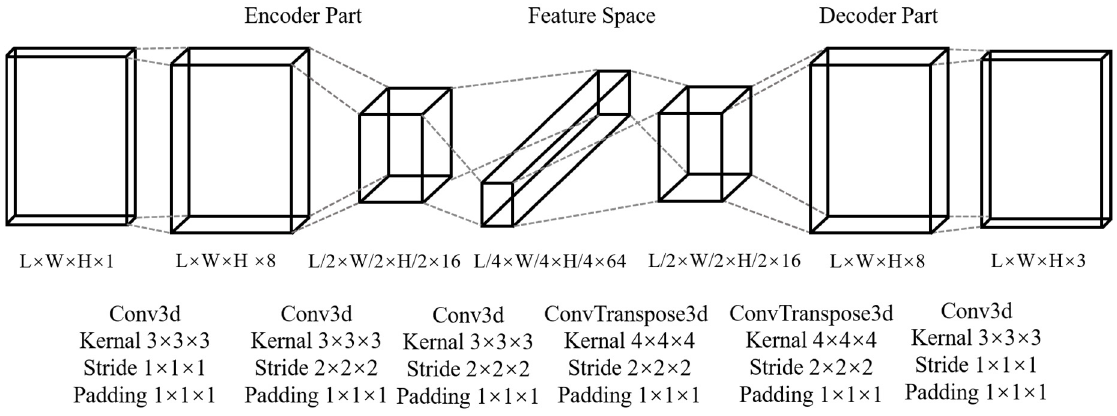
Figure 6. Schematic of the encoder-decoder CNN. Feature maps are depicted as solid boxes. Convolutional layers are depicted as gray dash lines. 𝐿 × 𝑊 × 𝐻 × 𝑐ℎ𝑎𝑛𝑛𝑒𝑙𝑠 represents the dimensions of each feature map. L, W, and H represent the resolution of the input image in windwise, spanwise and vertical directions, respectively. The layer type, filter size, and stride size of each layer are shown below it. Strides represent the movement step-size of the convolutional filter.